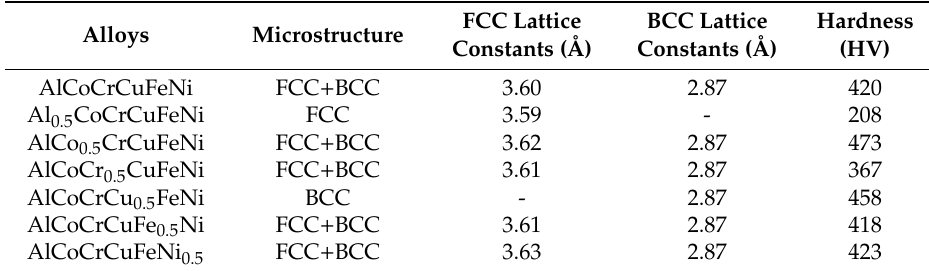
Table 2. Microstructure, lattice constants and hardness. Reproduced from Tung et al. [180]. Copyright 2006 Elsevier B.V. All rights